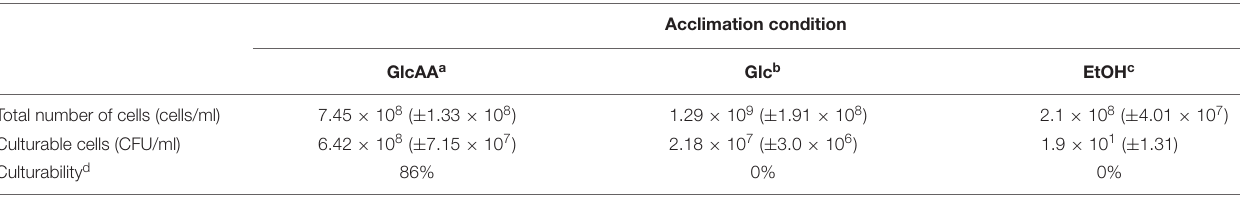
a GlcAA condition: acclimation to a mixture of glucose and acetic acid in regulated pH (pH 3.9 ± 0.1), b Glc condition: acclimation glucose in regulated pH (pH 3.9 ± 0.1), c EtOH condition: acclimation to a mixture of glucose and ethanol in regulated pH (pH 3.9 ± 0.1). d Culturability: the ratio of culturable cells to the total number of cells. Results are representative of three independent experiments and are expressed as mean ± SD (error bars) of three replicates.